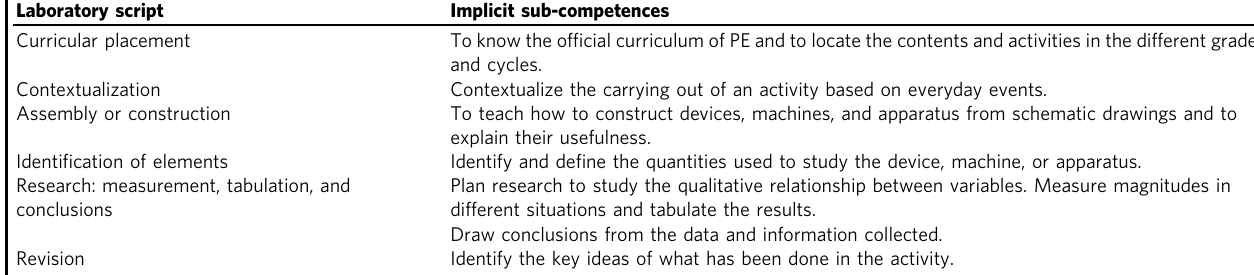
Table 4 Sub-competencies included in the